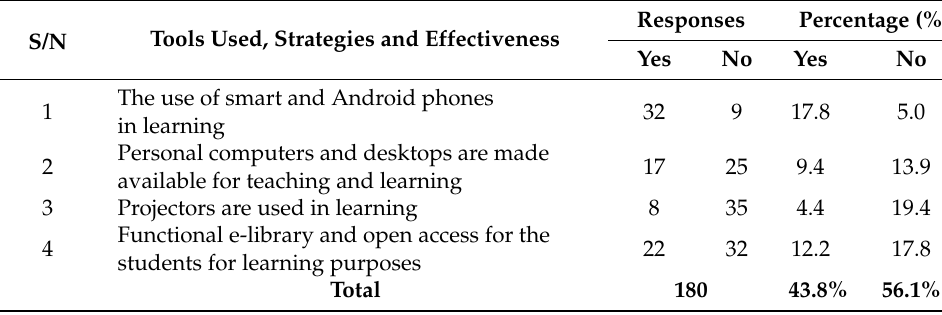
Table 2. Tools and strategies for effective e-learning Implementation. S/N